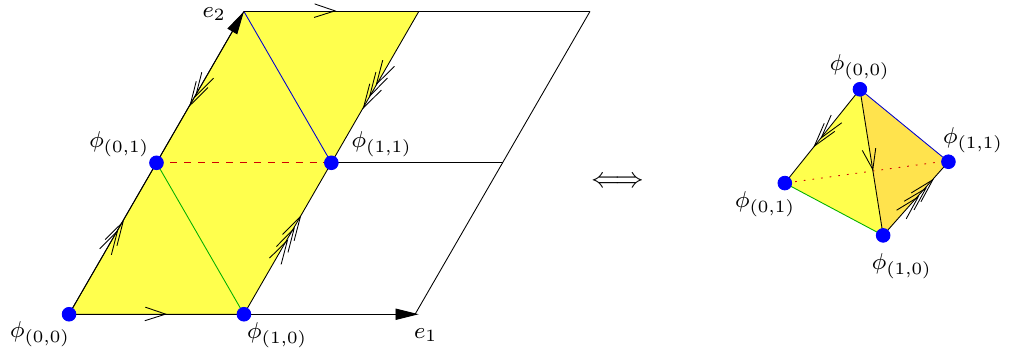
Figure 5 . The T 2 / Z 2 orbifold with h U i = e π i 3 . Identifying the arrows indicated on the boundaries of the fundamental domain of the orbifold yields a tetrahedron, whose vertex corners correspond to the four fixed points of the orbifold, where twisted matter fields φ